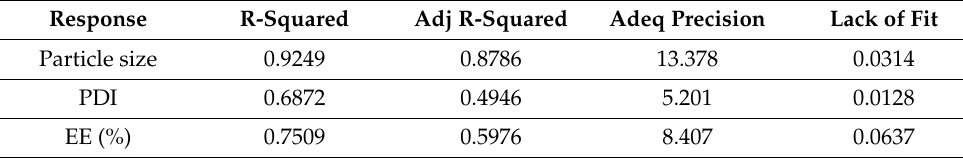
Table 4. Results of regression analysis for three